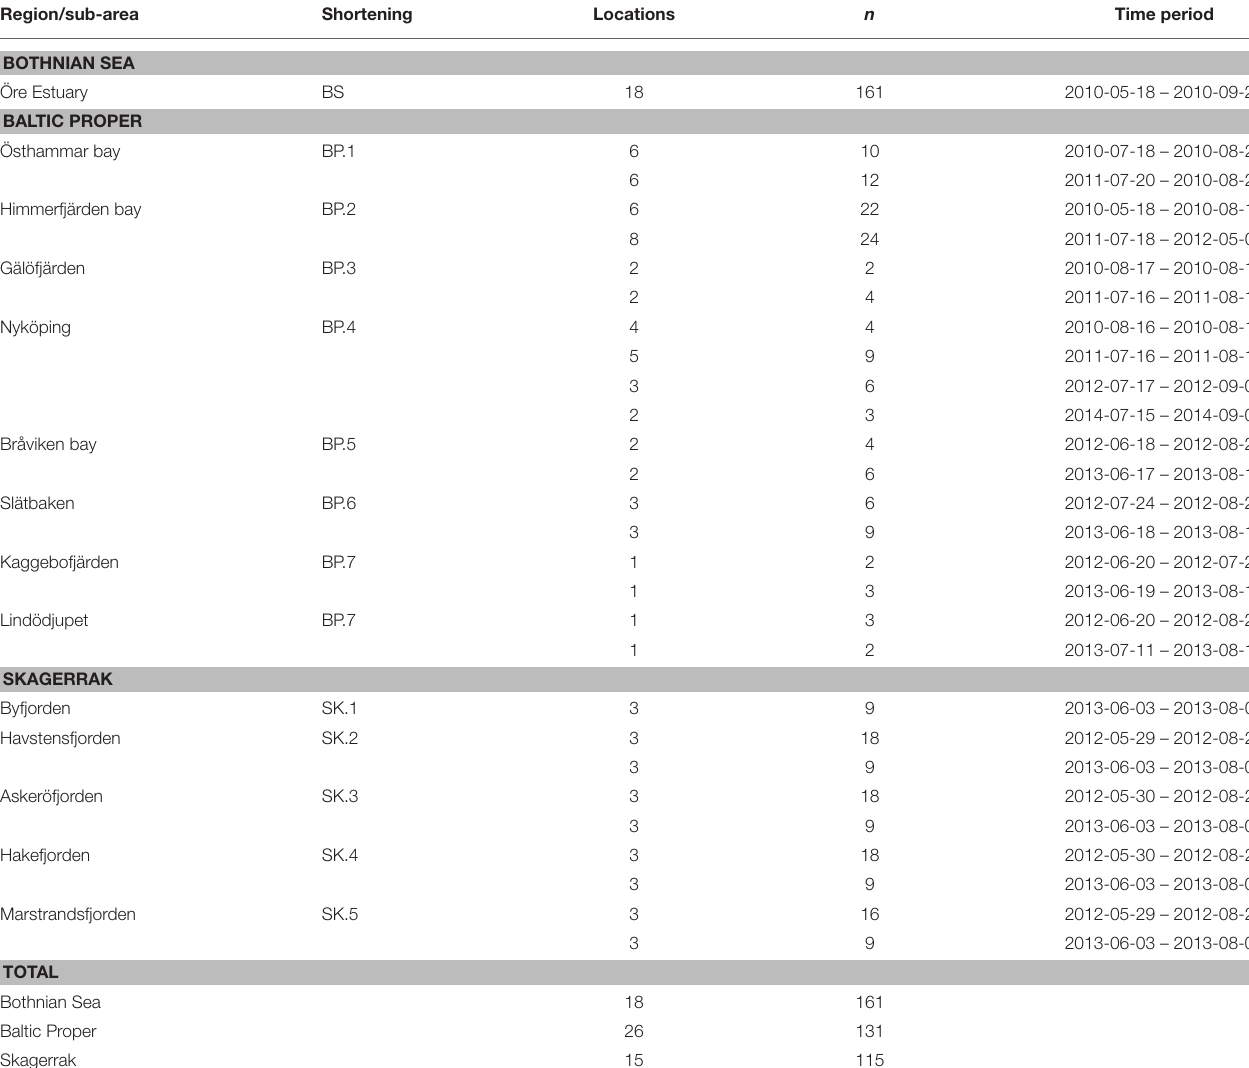
TABLE 1 | Locations (sampling stations), number of observations (n), and measurement periods for regions and